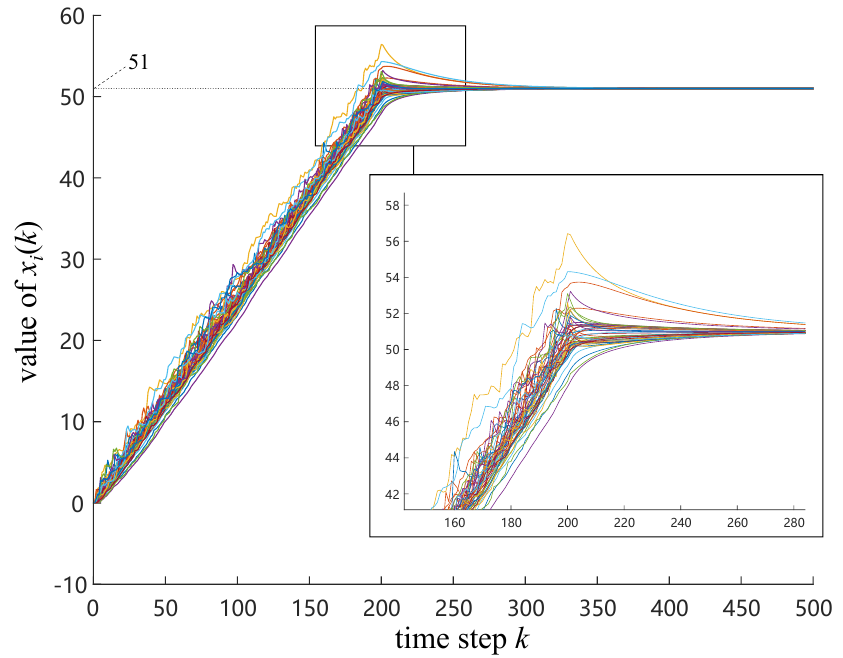
Figure 15. States evolution under exponential distribution of r i ( k )